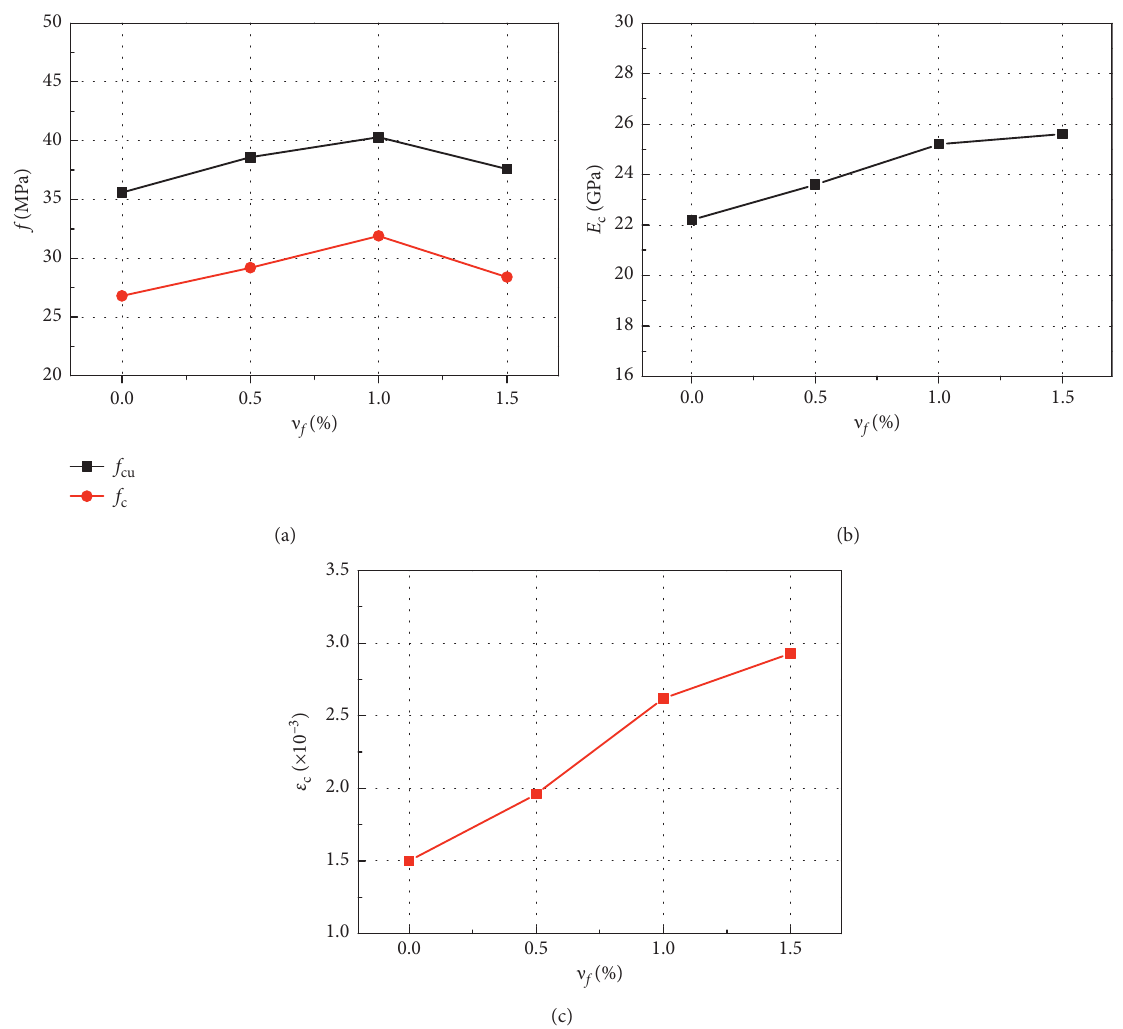
Figure 5: Effects of the steel fiber content: (a) f